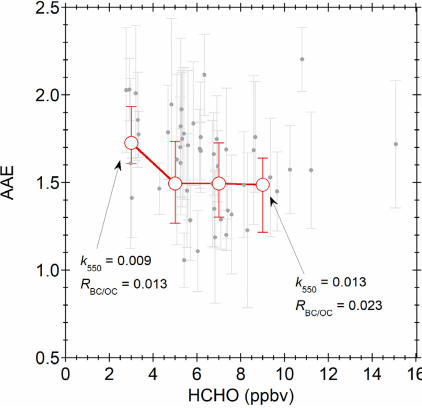
Figure 4. AAE values plotted as a function of HCHO